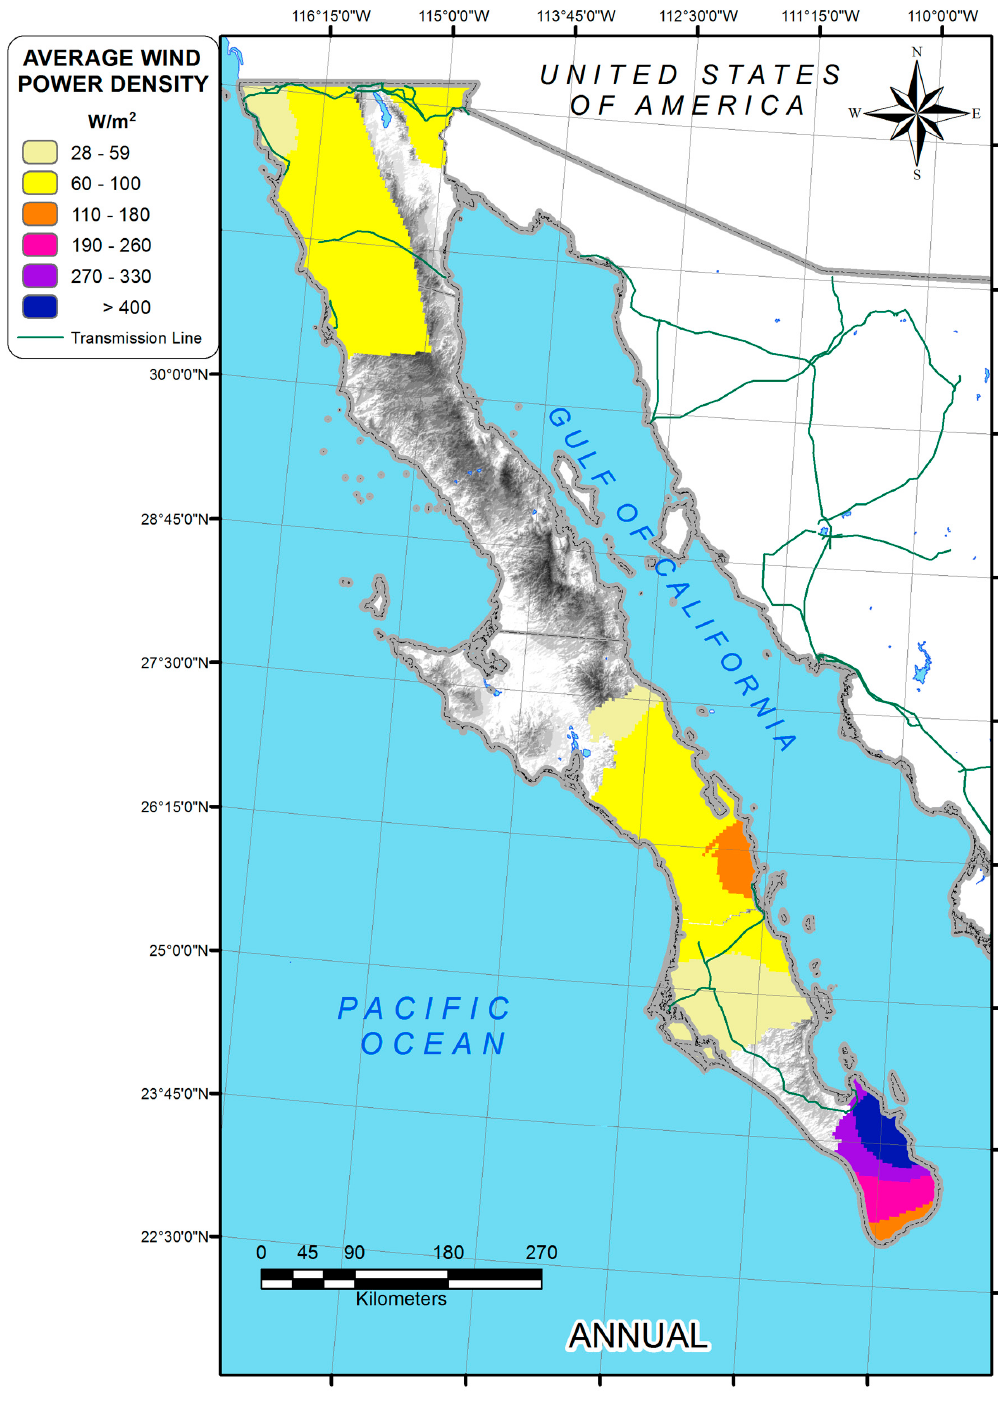
Figure 15. Annual WPD.